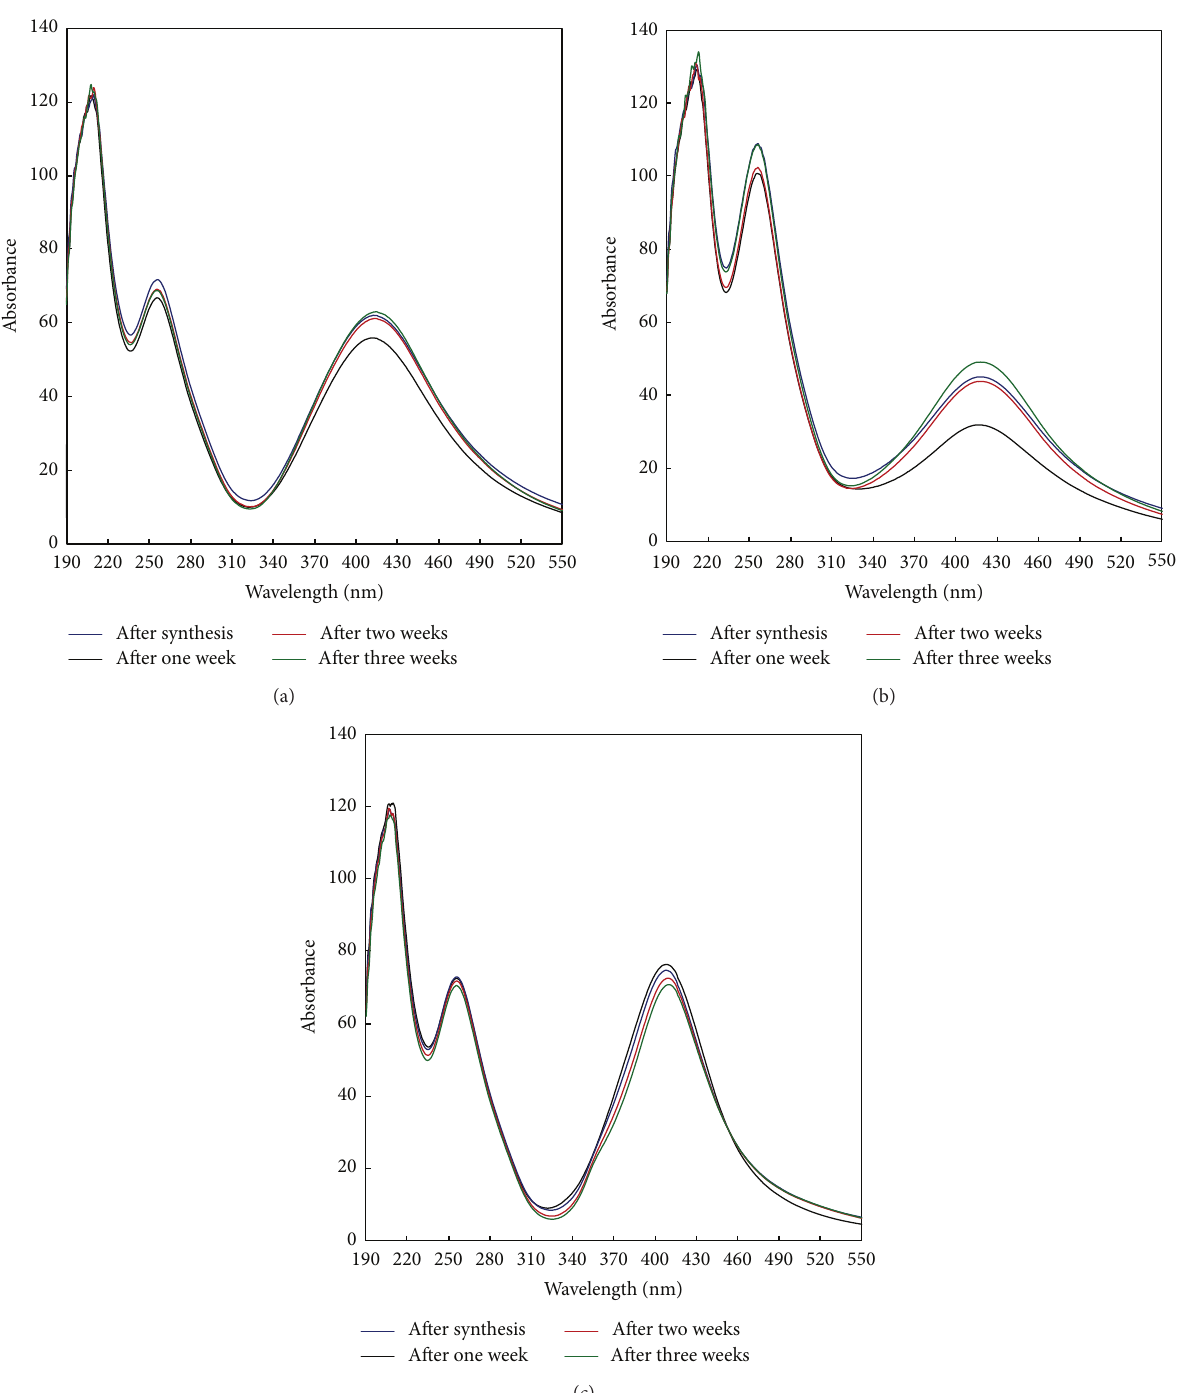
Figure 6: Stability of silver nanoparticles synthesized at different conditions after one week, two weeks, and three weeks of storing. (a) [CMS], 50 g/L; [PI], 1g/L; [AgNO 3 ], 1g/L; temp., 30 ∘ C; time, 60min.; M: L ratio, 1:20; pH, 7. (b) [CMS], 50g/L; [PI], 1g/L; [AgNO 3 ], 1.5 g/L; temp., 30 ∘ C; time, 60min.; M: L ratio, 1: 20; pH, 7. (c) [CMS], 10g/L; [PI], 1g/L; [AgNO 3 ], 1g/L; temp., 30 ∘ C; time, 60 min.; M:L ratio, 1 :20; pH,